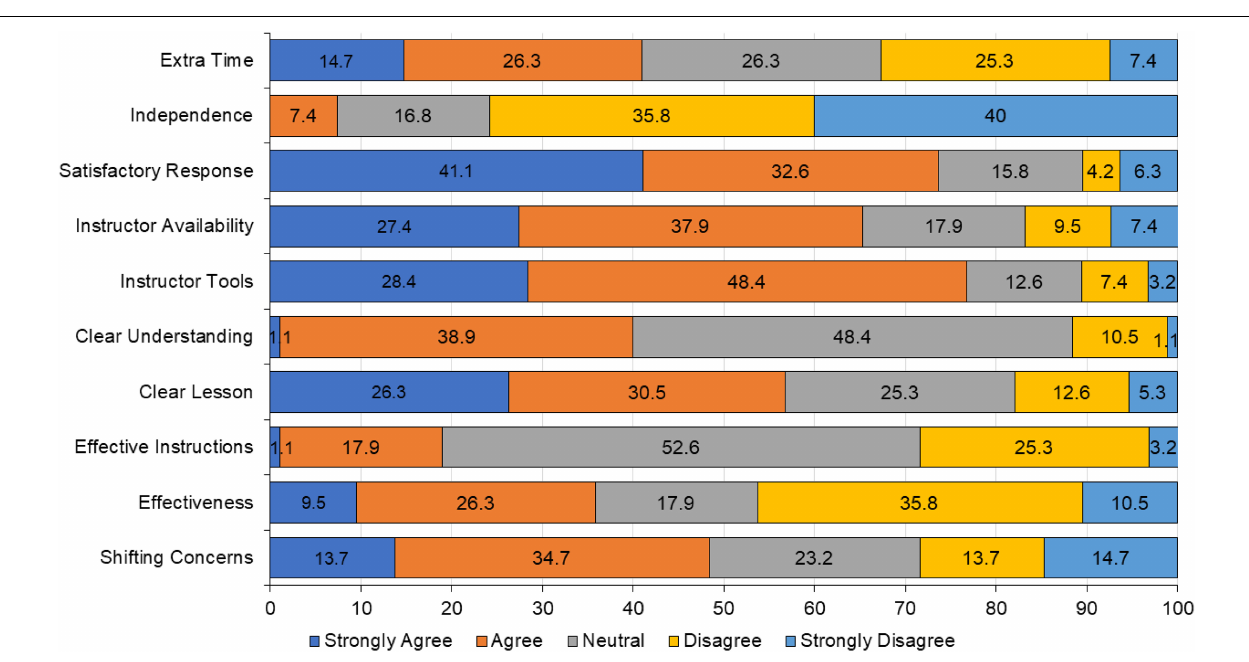
FIGURE 4 | Rating percentages of different face-to-face learning parameters by Likert